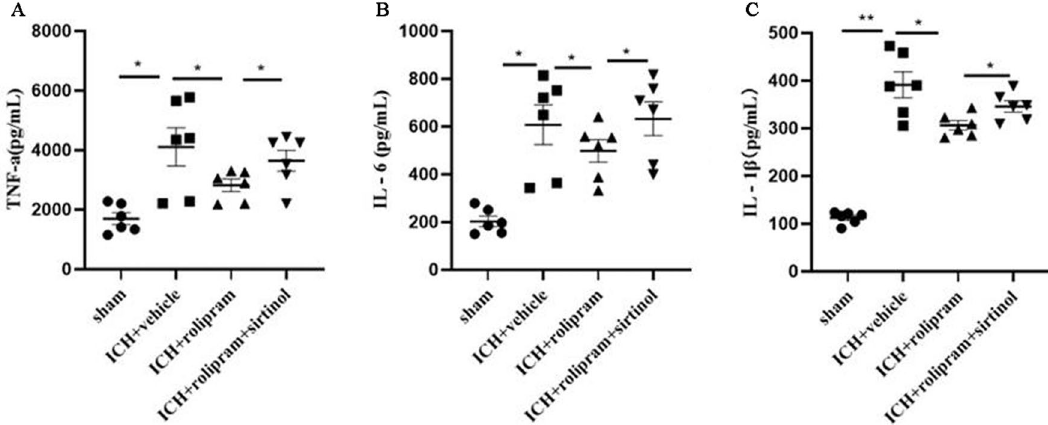
Figure 5. Rolipram alleviated the inflammatory environment in the brain after ICH. ( A – C ) TNF-α, IL-6, and IL-1β expression levels in the different groups. The Mann–Whitney U test was used to compare differences between groups in ELISA. The data are presented as the means ± SEM. * p < 0.05, ** p < 0.01.